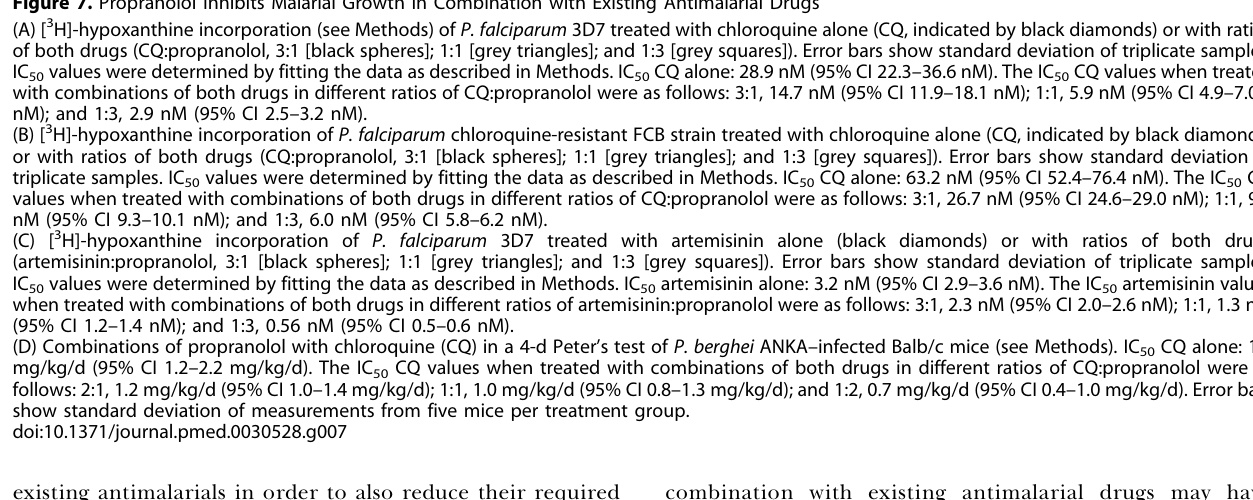
Figure 7. Propranolol Inhibits Malarial Growth in Combination with Existing Antimalarial